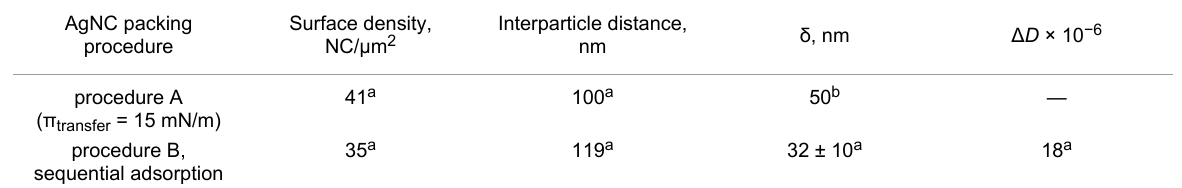
Table 1: Structural parameters for AgNC arrays on silicon oxide.